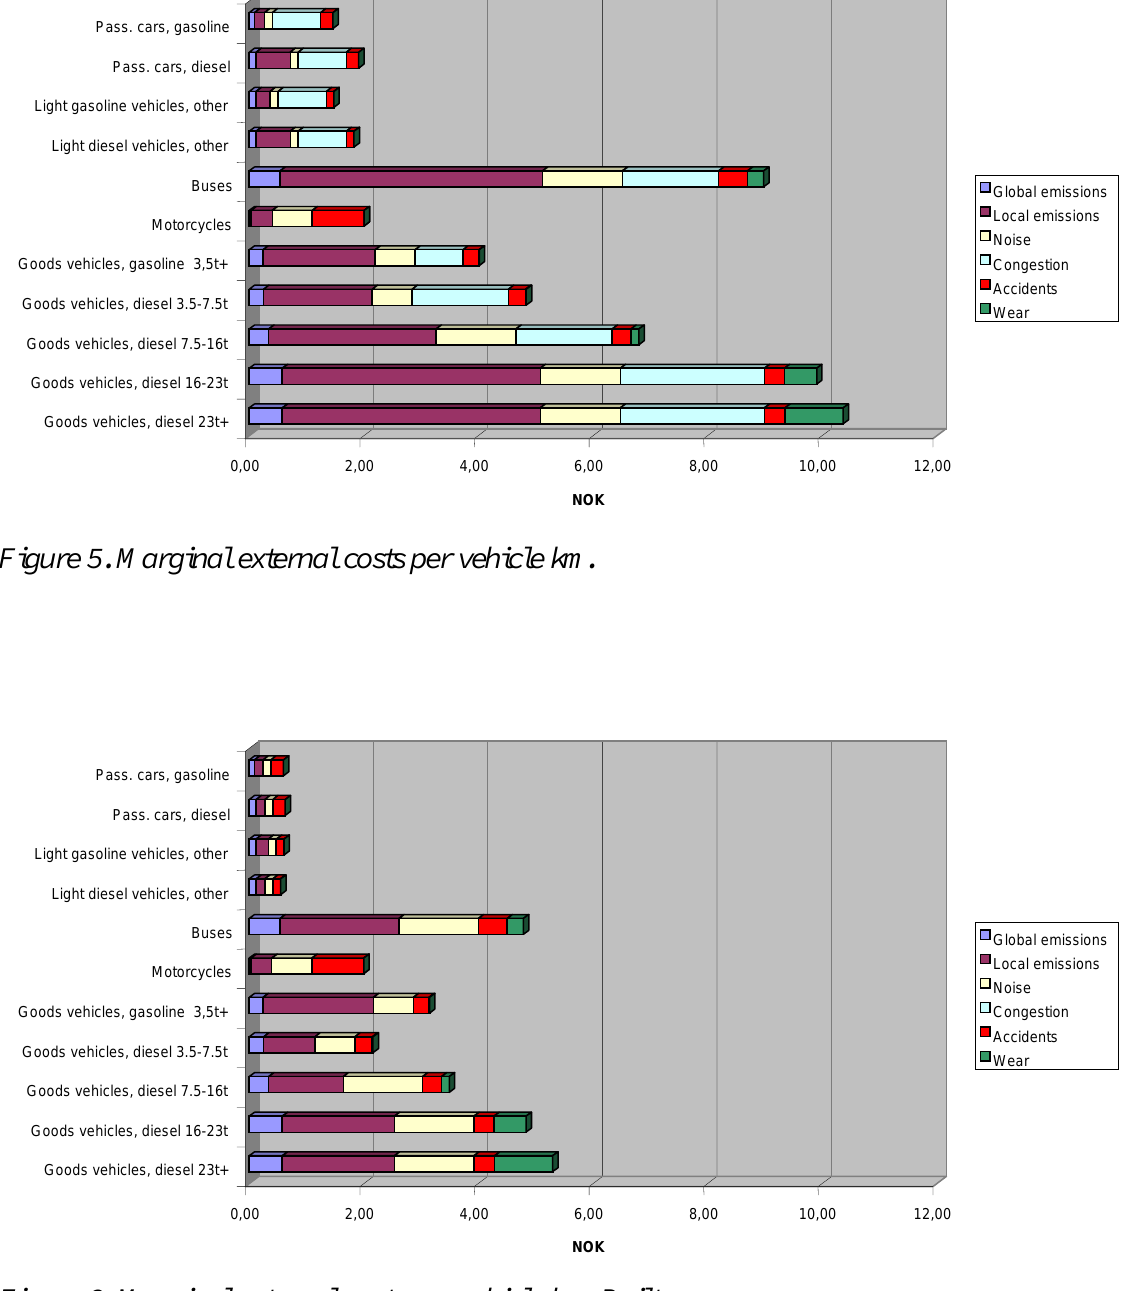
Figure 6. Marginal external costs per vehicle km. Built-up